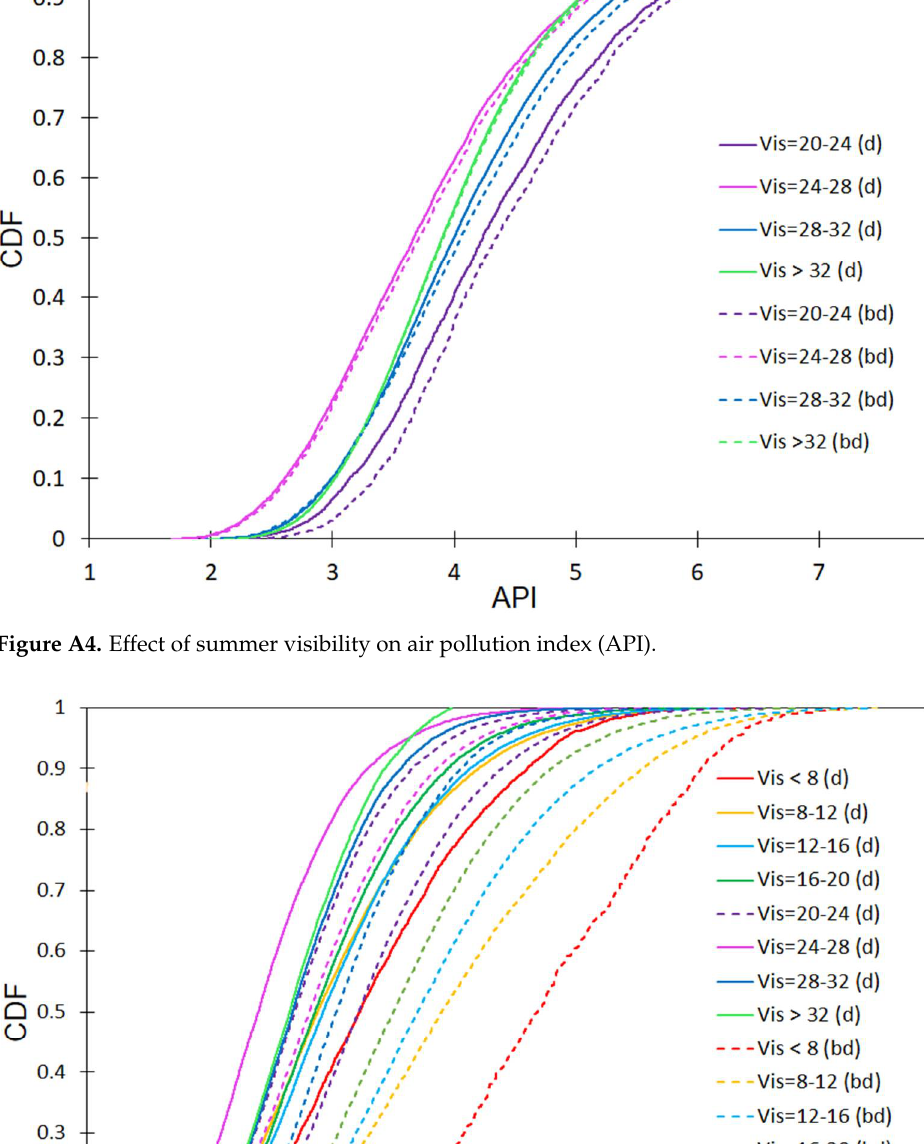
Figure A3. Number of days (D z ) with visibility in the respective range of variability for the period precipitation and rainless period for the winter season.